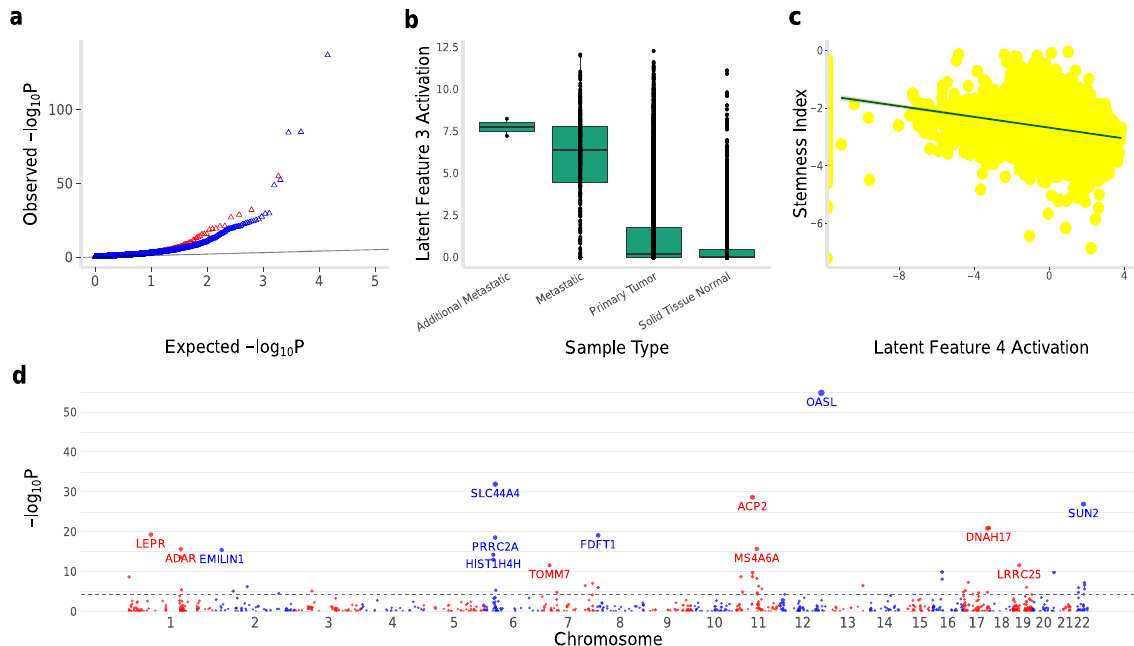
Fig. 7 Integrating communities into TWAS and Variational Autoencoder. Leveraging the communities in genomic studies of disease may improve identi fi cation of disease-associated genes and enable unique biological insights. a We performed a transcriptome-wide association study (TWAS) of C-reactive Protein (CRP) in 361,194 UK Biobank individuals using PrediXcan. CRP is a biomarker for a wide range of complex diseases. The set of genes in the communities (red) displayed a greater departure from the null expectation (i.e., greater enrichment for signi fi cant associations) than the complement set of genes (blue), as shown by the leftward shift in the Q – Q plot. b We implemented a variational autoencoder (VAE) to leverage the power of neural networks in high-dimensional molecular data. Using 11,060 samples across 33 cancer types from TCGA, the VAE learned biologically-meaningful latent spaces from the communities. For example, latent feature three separates metastatic tumors from primary tumors and normal solid tissues (Mann – Whitney U -test p < 2.2 × 10 − 16 for each comparison), representing a potential mechanism for metastasis. Median line and scatter points are shown. Box edges show interquartile range. c The VAE model learned a stemness index signi fi cantly associated ( p < 2.2 × 10 − 16 ) with a DNA-methylation-based index. Least-squares regression line is shown. d Manhattan plot shows TWAS associations with CRP for the genes in the communities (dashed line is Bonferroni-adjusted p <